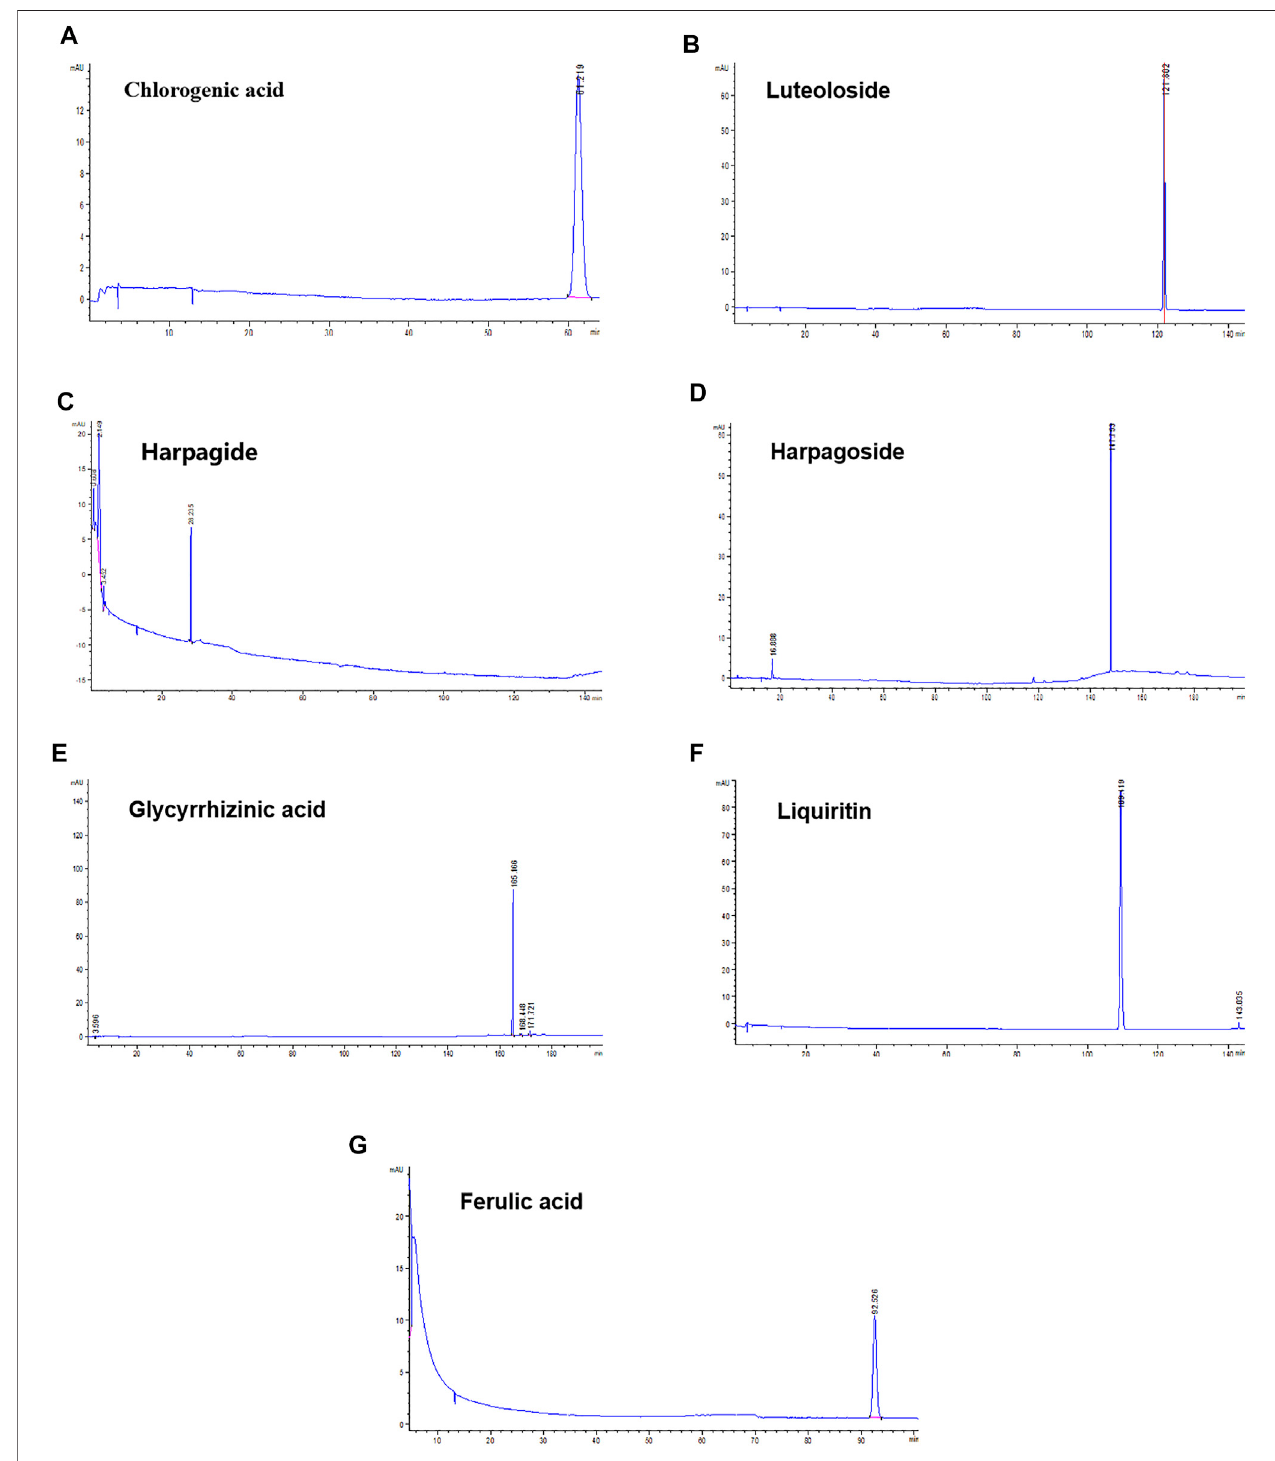
FIGURE 1 | HPLC analysis. HPLC chromatogram of reference compounds including (A) chlorogenic acid, (B) luteoloside, (C) harpagide, (D) harpagoside, (E) glycyrrhizinic acid, (F) liquiritin, and (G) ferulic acid. HPLC chromatogram of (H) SMYAD and (I) SMYAD in area Ⅰ and (J) SMYAD in area Ⅱ .